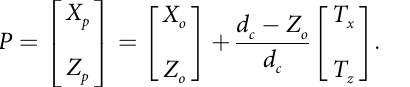
Fig 12. Effects of head translations horizontally ( x -axis) from the cyclopean eye (i.e., only monocular depth cues). (a) Left ( T − 30 cm ) and (b) right ( T x = 30 cm ). The brown cubes are the simulations in the original world and the blue cubes are the simulations in the reconstructed world. The black arrows show the cubes shear to the left and the right.